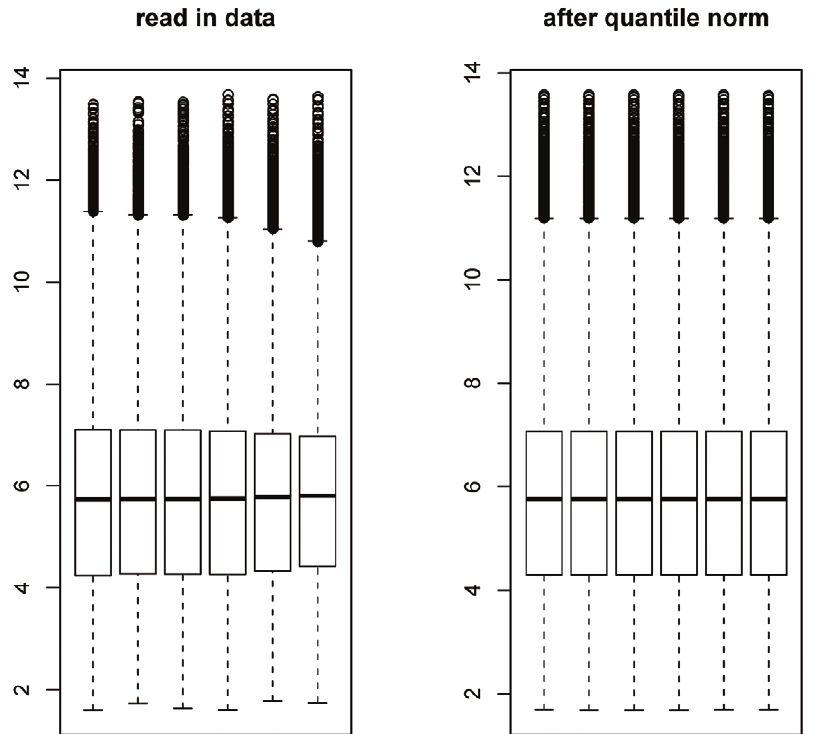
Figure 2. Box plot depicting the difference among microarray expression datasets (chips) before and after normalization by Robust Microarray Averaging (RMA). Boxes show the 25th and 75th percentiles in the distribution of log-transformed (log base 2) intensities. The median is the horizontal bar in the middle of the box. The whiskers (dotted lines extending from the boxes) illustrate the maximum value or 1.5 times the interquartile range of data (IQR), whichever is smaller. The circles display any points beyond these whiskers.